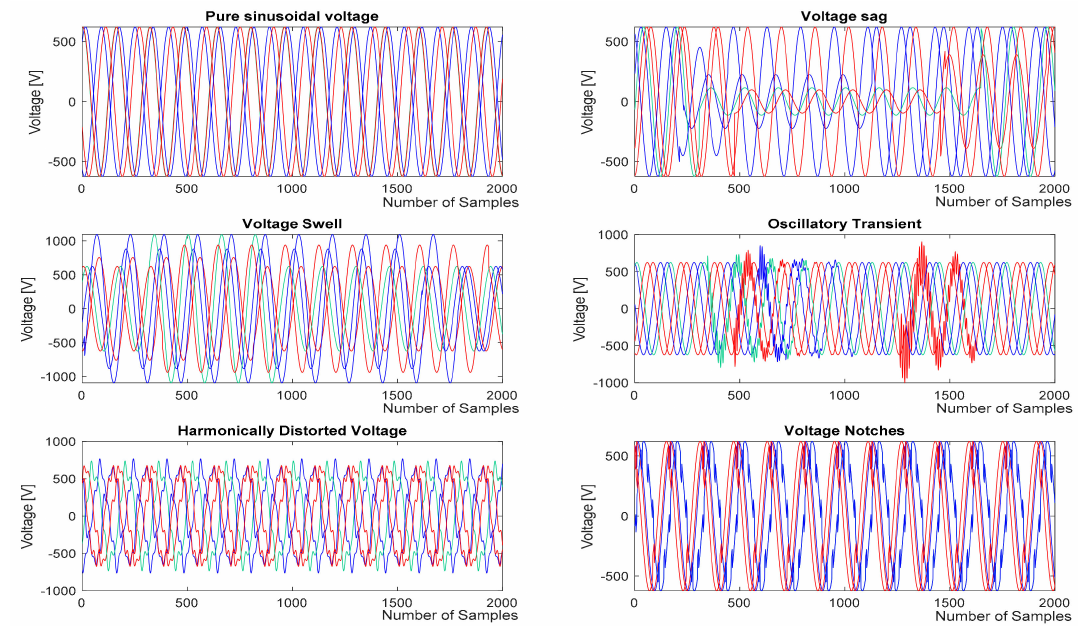
Figure 5. Samples of figures of the training data for each disturbance